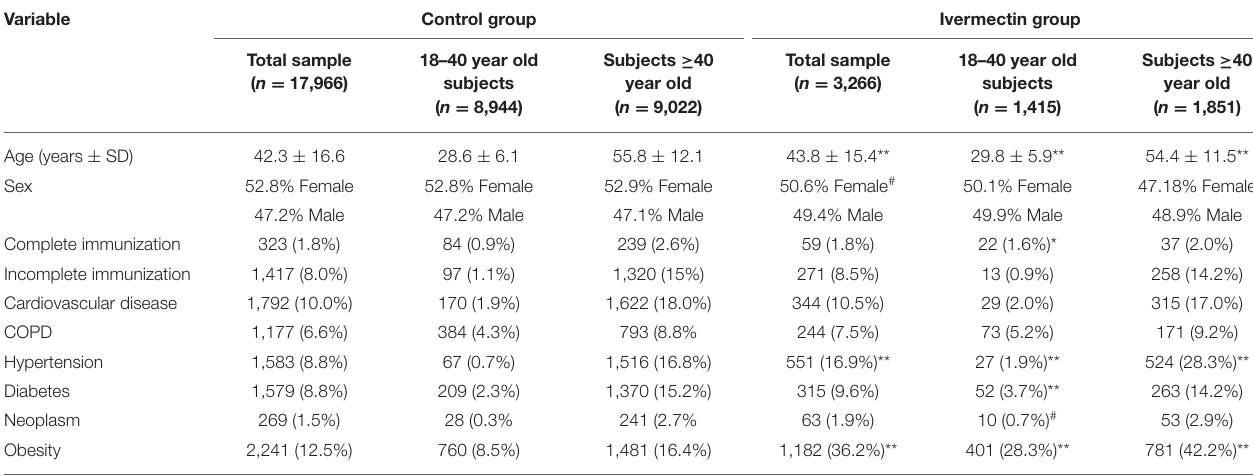
TABLE 1 | Descriptive characteristics of the sample.